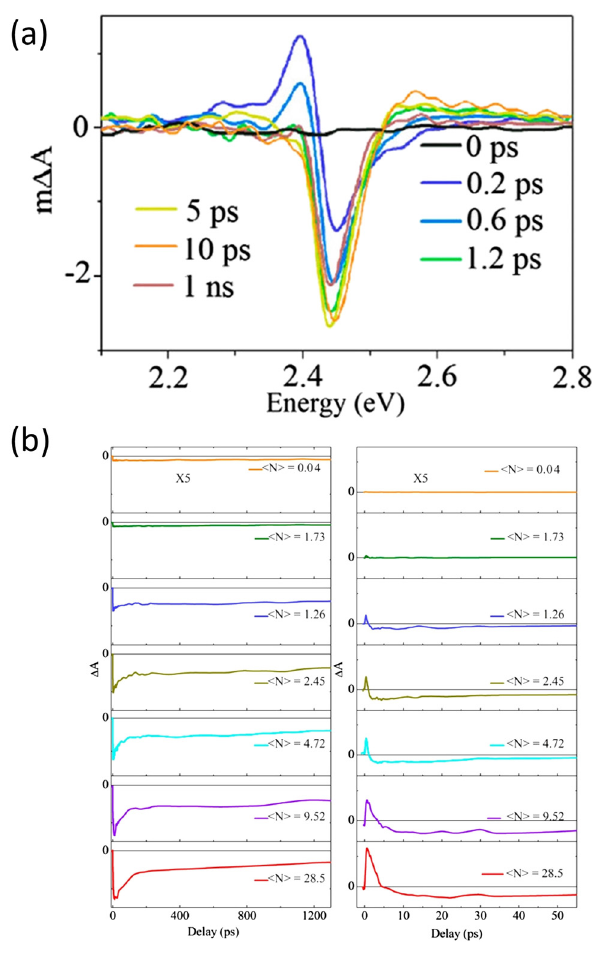
Figure4: (a)TA spectrumof CsPbBr 3 atdifferentdelaytimesCsbBr 3 (b) bleaching signal (c) absorption signal of CsPbBr 3 nano-crystals under different pump injections [47].